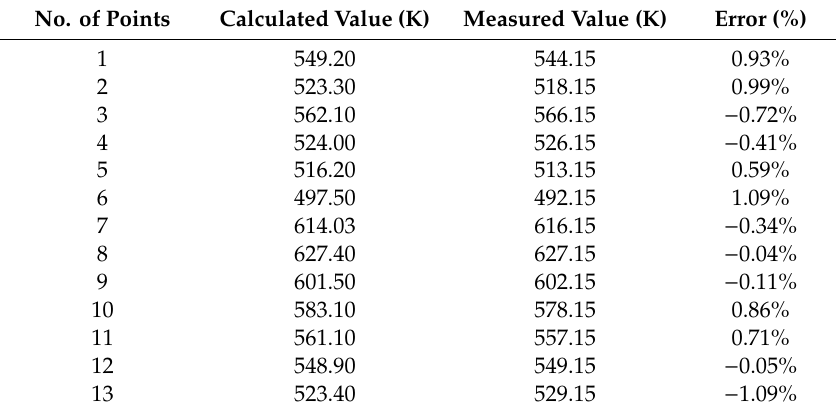
Figure 14. Positional relationship of the measuring points. Table 6. Comparison of the error between calculation and measured values of temperature.